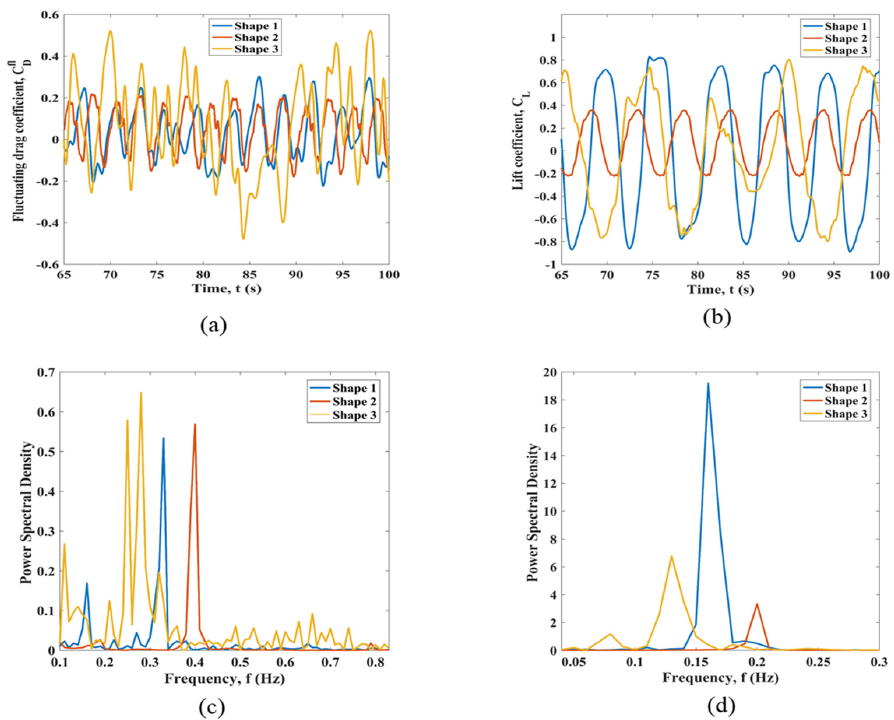
Figure 4. Fluid force coefficients for cylinder 1 immersed in uniform flow: ( a ) time history of the fluctuating drag coefficient; ( b ) time history of the lift coefficient; ( c ) the fluctuating drag coefficient FFT; ( d ) the lift coefficient FFT.